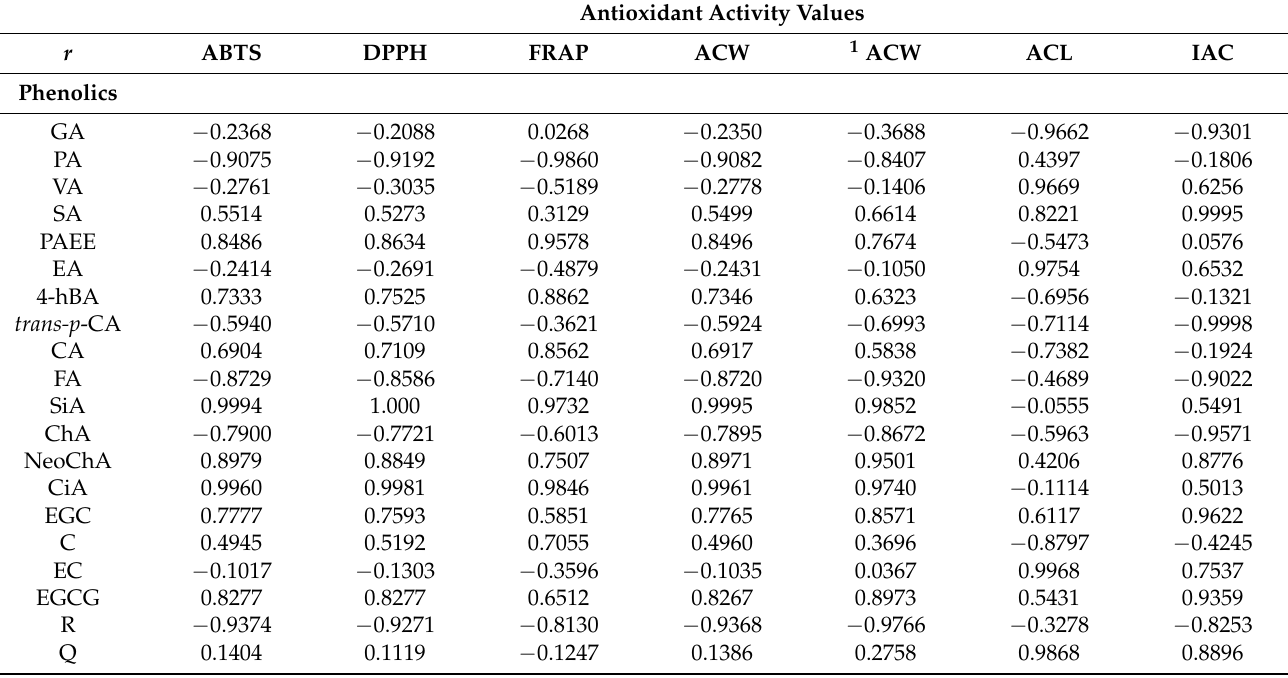
Table 6. The relationships between several evaluation parameters of undigested part of matcha. Antioxidant Activity